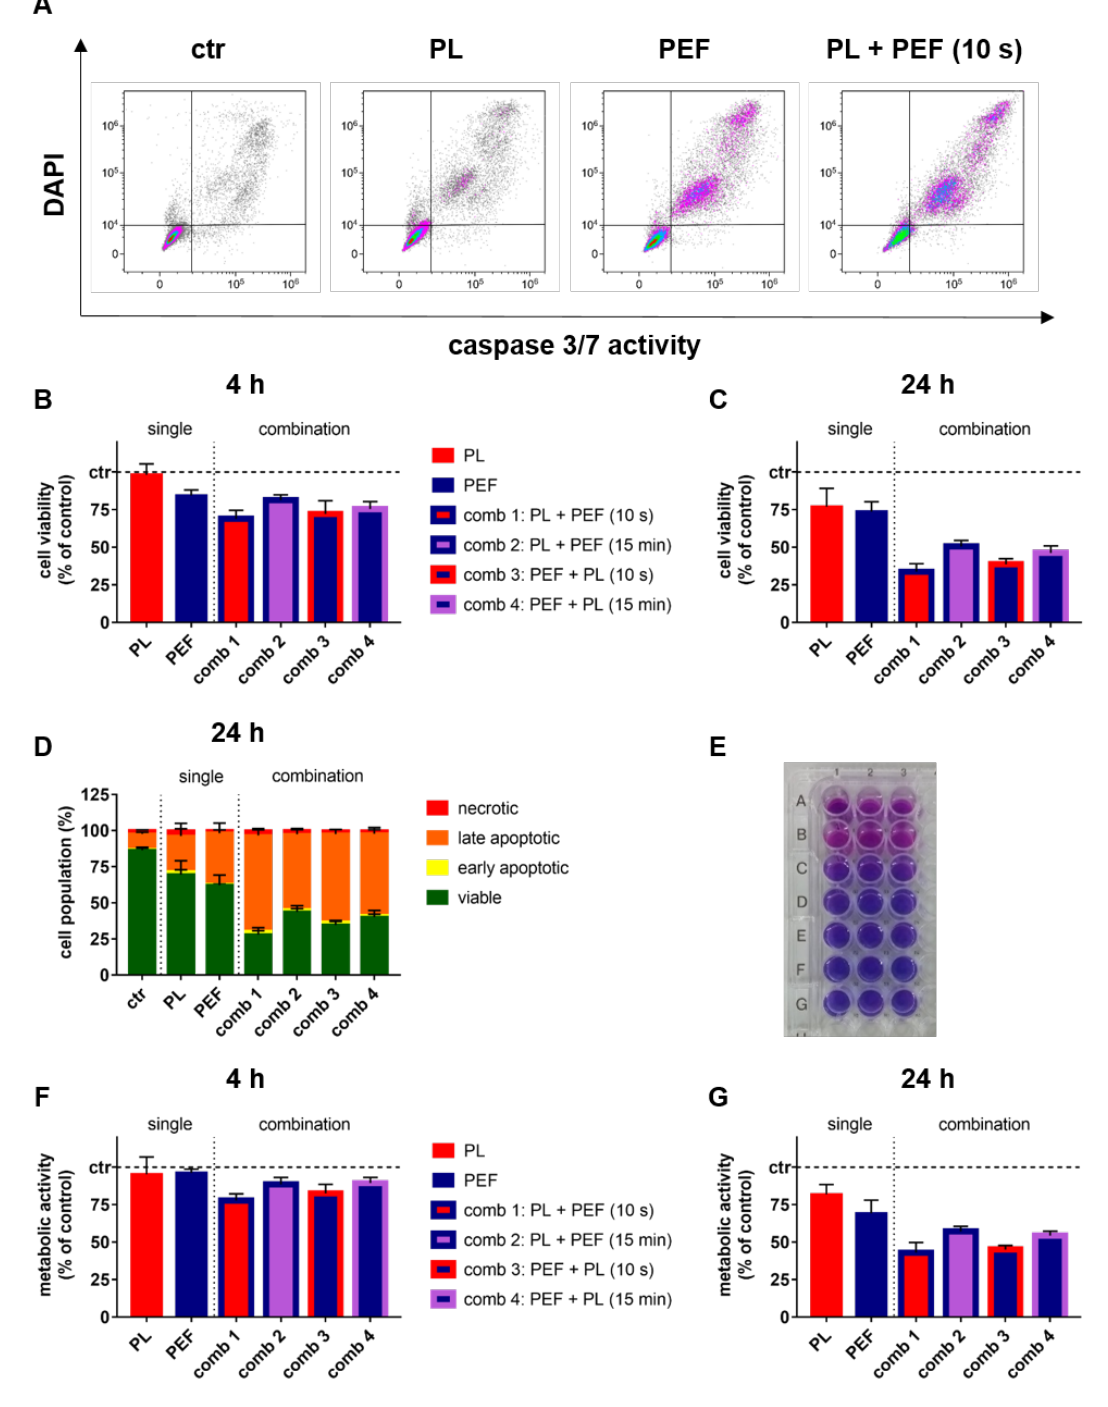
Figure 3. Cell viability and metabolic activity at 4 and 24 h after mono and combination treatments. The plasma exposure time was 40 s, and the electric field strength was 0.9 kV/cm. Percentages of viable, early, and late apoptotic, as well as necrotic cells were analyzed ( A ) and quantified ( B–D ) at 4 and 24 h using flow cytometry. The cell viability at 4 ( B ) and 24 h ( C ) is shown. The resazurin assay ( E ) was utilized to analyze the metabolic activity at 4 ( F ) and 24 h ( G ). The results of the t-test for the cell viability and metabolic activity are shown in Tables 2 and 3, respectively. Data are shown as one representative ( A and E ) or mean + S.E. ( B–D , F , and G ) of three independent experiments. ctr = control; PL = plasma; PEF = pulsed electric fields; comb = combination.